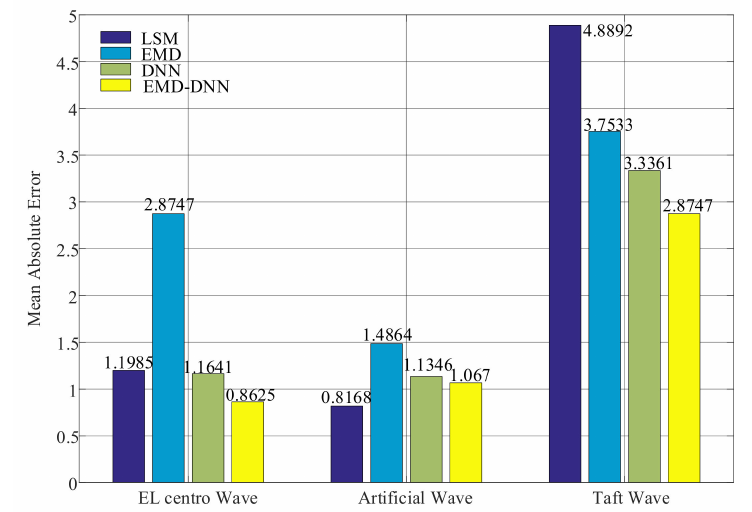
Figure 12. Mean absolute error (MAE) of different correction